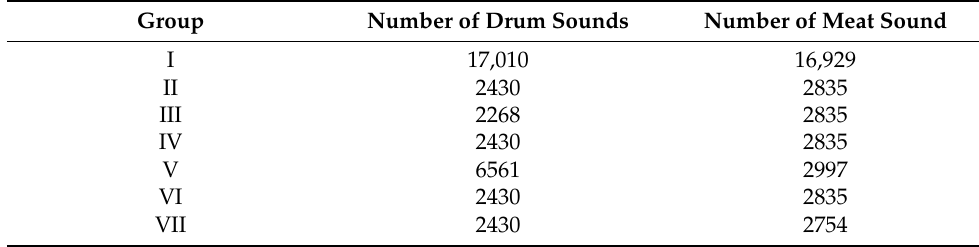
Table 6. Number of hit sounds after augmentation.